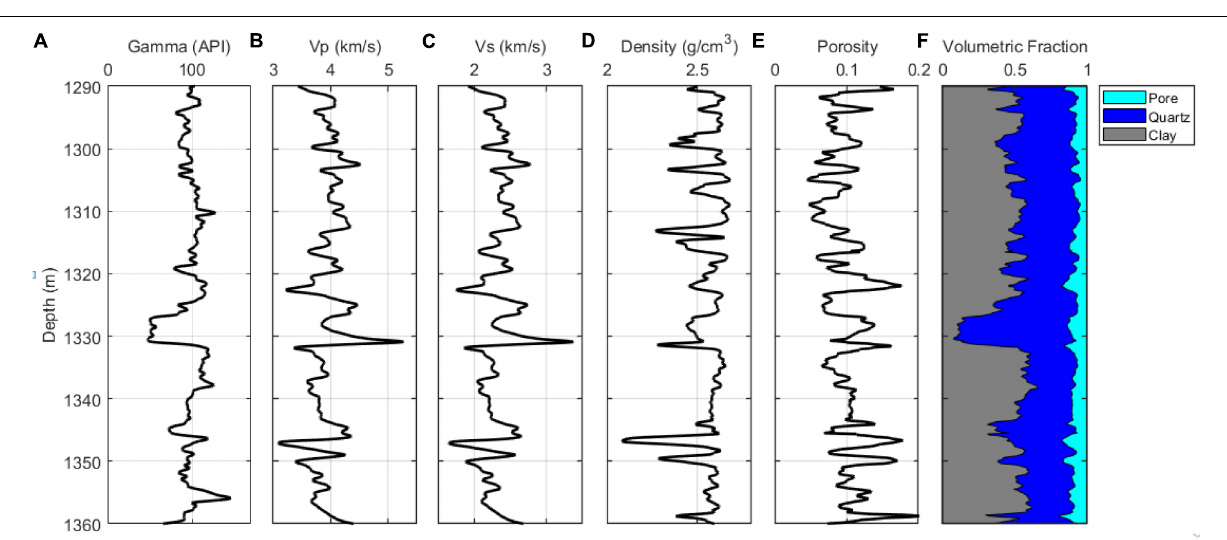
FIGURE 8 | Logging data for the tight sandstone reservoir. (A) Gamma; (B) Vp; (C) Vs; (D) density; (E) porosity; and (F) volumetric fraction of